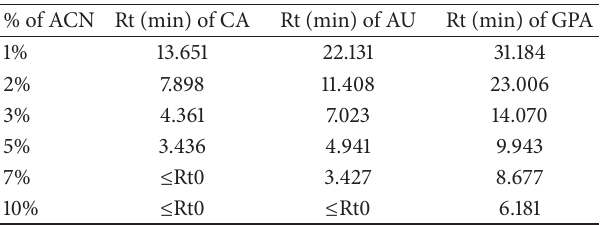
Table 2: Elution time of three analytes under different concentra- tions of